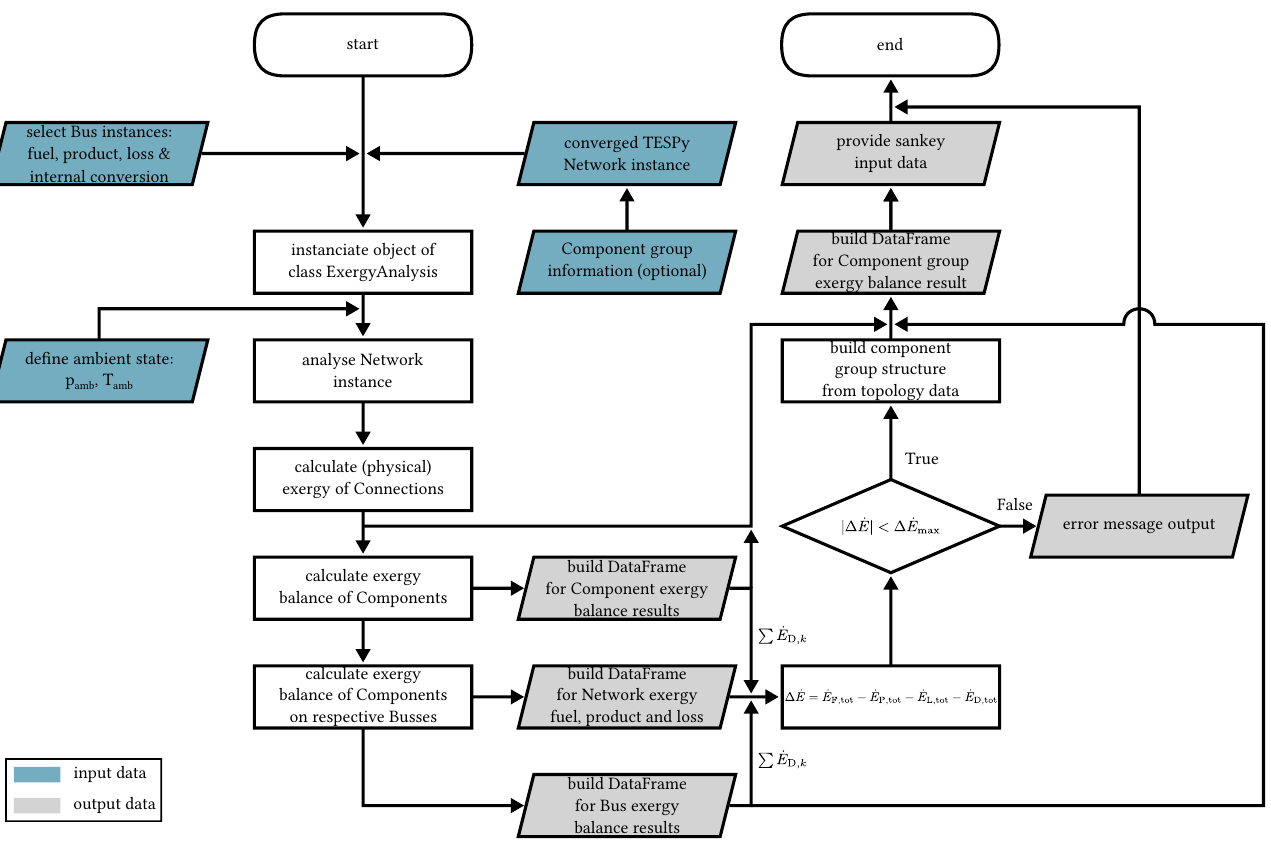
Figure 4. Simplified flowchart of the exergy analysis in